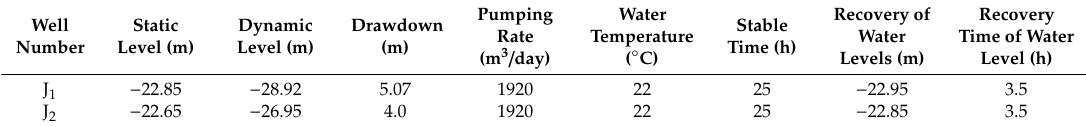
Table 1. Statistics parameters of pumping and recovery water tests.